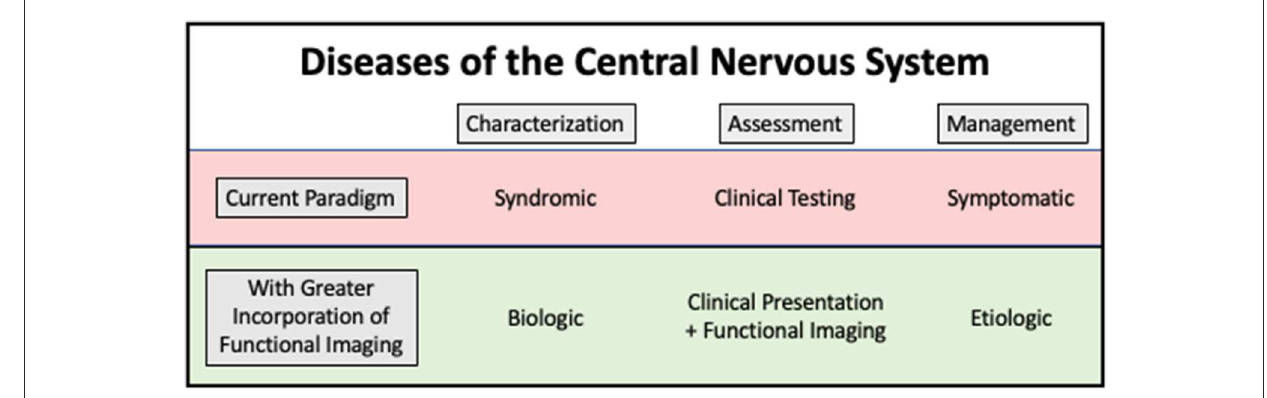
FIGURE1 Conceptual model showing how functional imaging has the potential to change our approach to treatment and monitoring of central nervous system diseases. By using functional imaging to understand biology and pathogenesis, underlying causes of disease can be more effectively addressed.